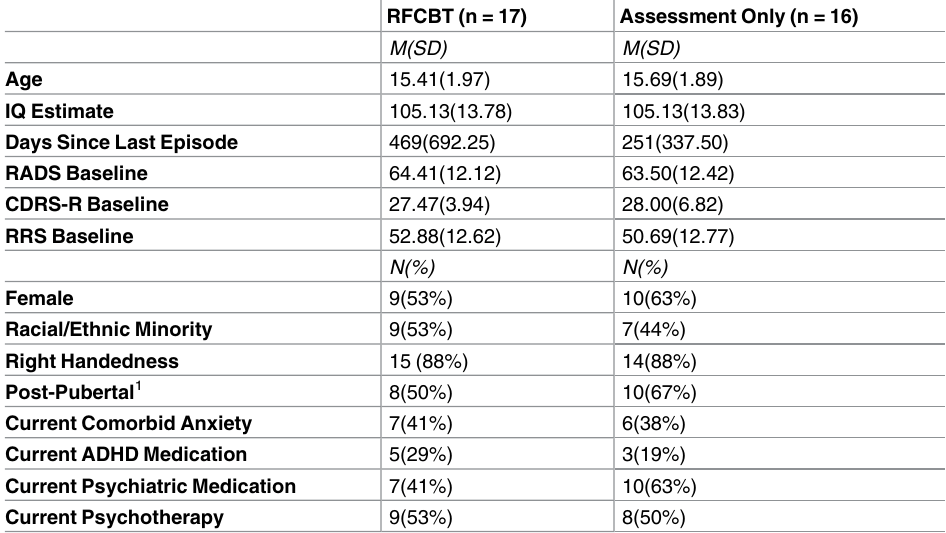
Table 1. Demographics and Clinical Characteristics of Intent-to-Treat Sample.